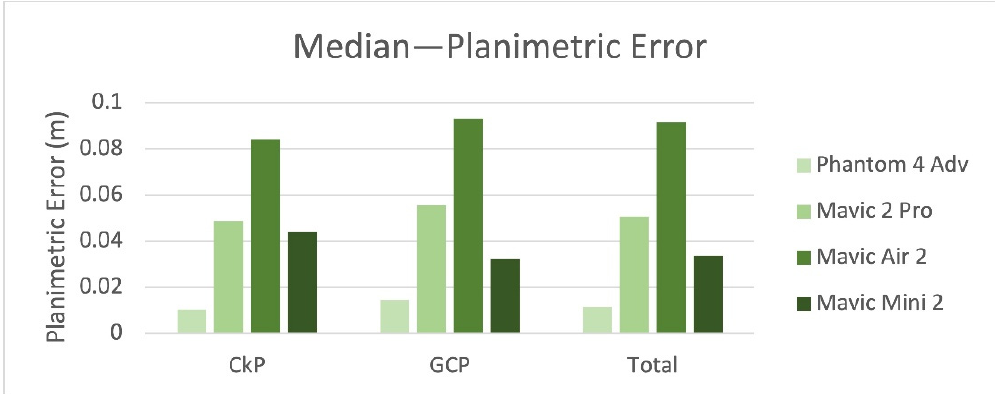
Figure 14. Chart of median calculated for the planimetric error.